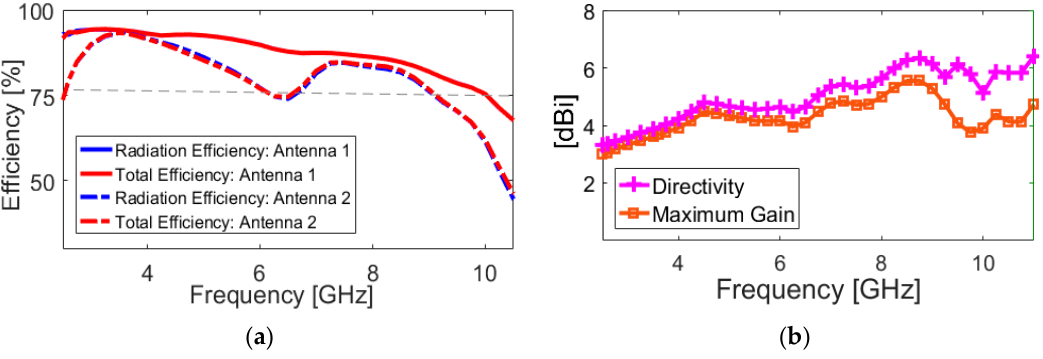
Figure9. ( a )Radiation / totale ffi ciencies, maximumgainand( b